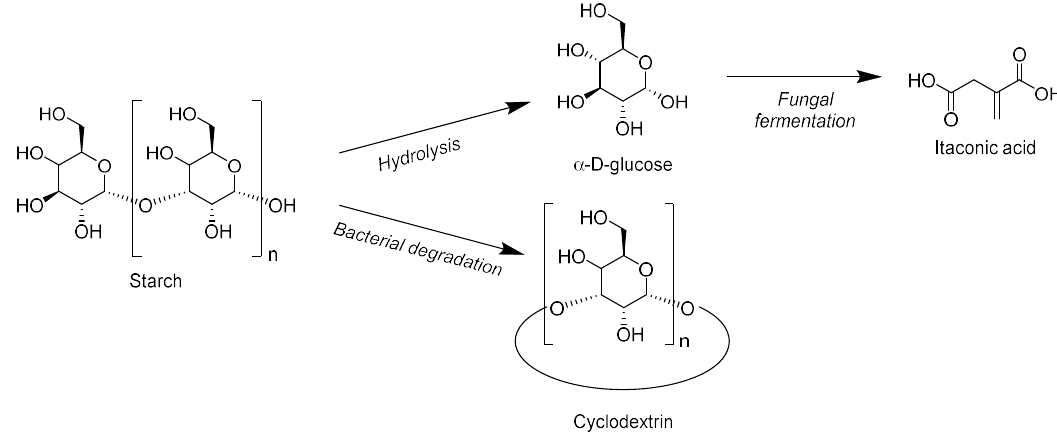
Figure 9. Starch and its derivatives used as flame retardants.